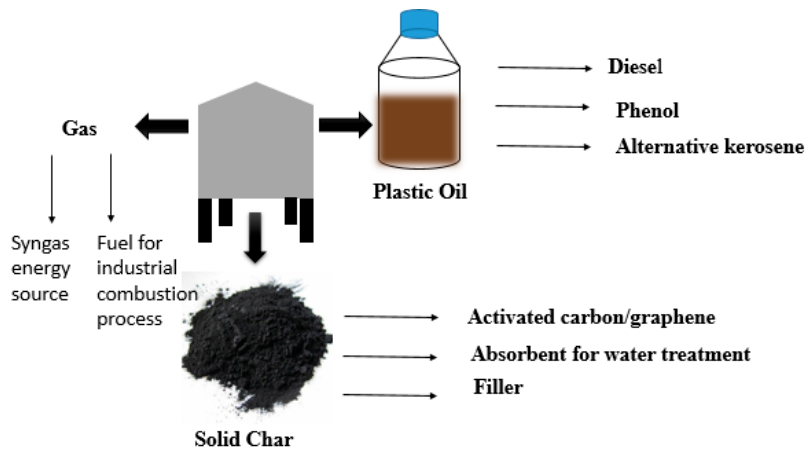
Figure 5. Application of the pyrolysis oil, char, and gaseous hydrocarbons [58]. Figure 4. Application of the pyrolysis oil, char, and gaseous hydrocarbons